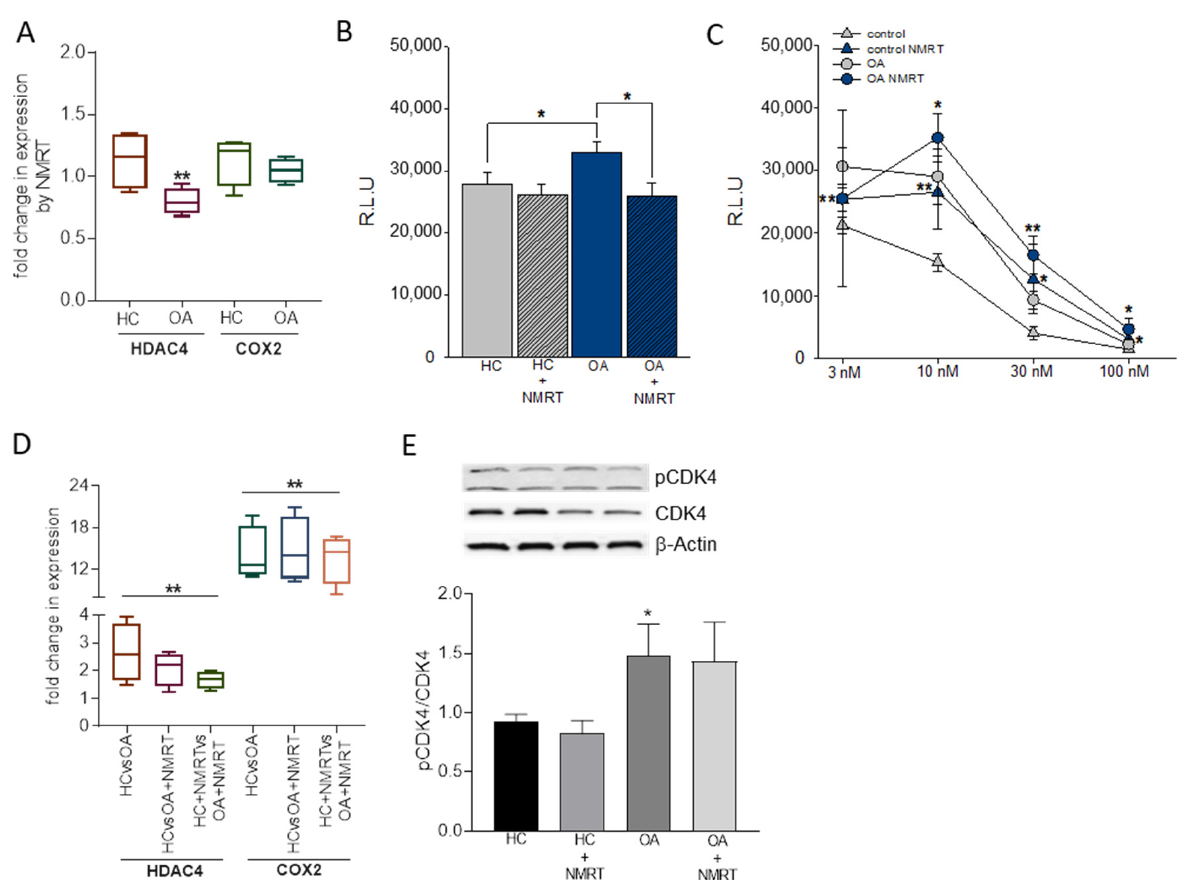
Figure 2. Influence of NMRT on HDAC, COX2 and CDK4 phosphorylation. NMRT induced changes in the expression of HDAC4 and COX2 ( A , D ) and the activity (R.L.U., relative luminescence units) of HDAC I/II ( B ) in control (HC) and OA cells are shown. ( A ) summarizes the NMRT induced changes in expression of HC and OA cells (untreated cells functioned as calibrators). Concentration response curve for the inhibition of HDACI/II activity by trichostatin (nM) with or without NMRT treatment in ( C ) ( n = 3). The box-plot in D represents the difference in expression of HDAC4/COX2 of OA cells (OA) or OA cells treated with NMRT (OA NMRT ) compared to HC (HC untreated functioned as calibrator; HC/OA; HC/OA NMRT ); treated OA cells were further compared with NMRT treated HC cells leading to HC NMRT /OA NMRT (HC NMRT cells as calibrator); n = 4 and each experiment was executed in duplicates. Significant changes compared to the respective calibrator are given: *: p < 0.021 and **: p = 0.004. CDK4 phosphorylation by western blotting and phospho-CDK4 normalization to CDK4 is shown ( E ). The statistical significance for the bar charts and inhibitor study was evaluated by using the Student’s t -test while the differences in median values represented by the box-plots were calculated via the Mann–Whitney Rank Sum test; *: p < 0,05; **: p <